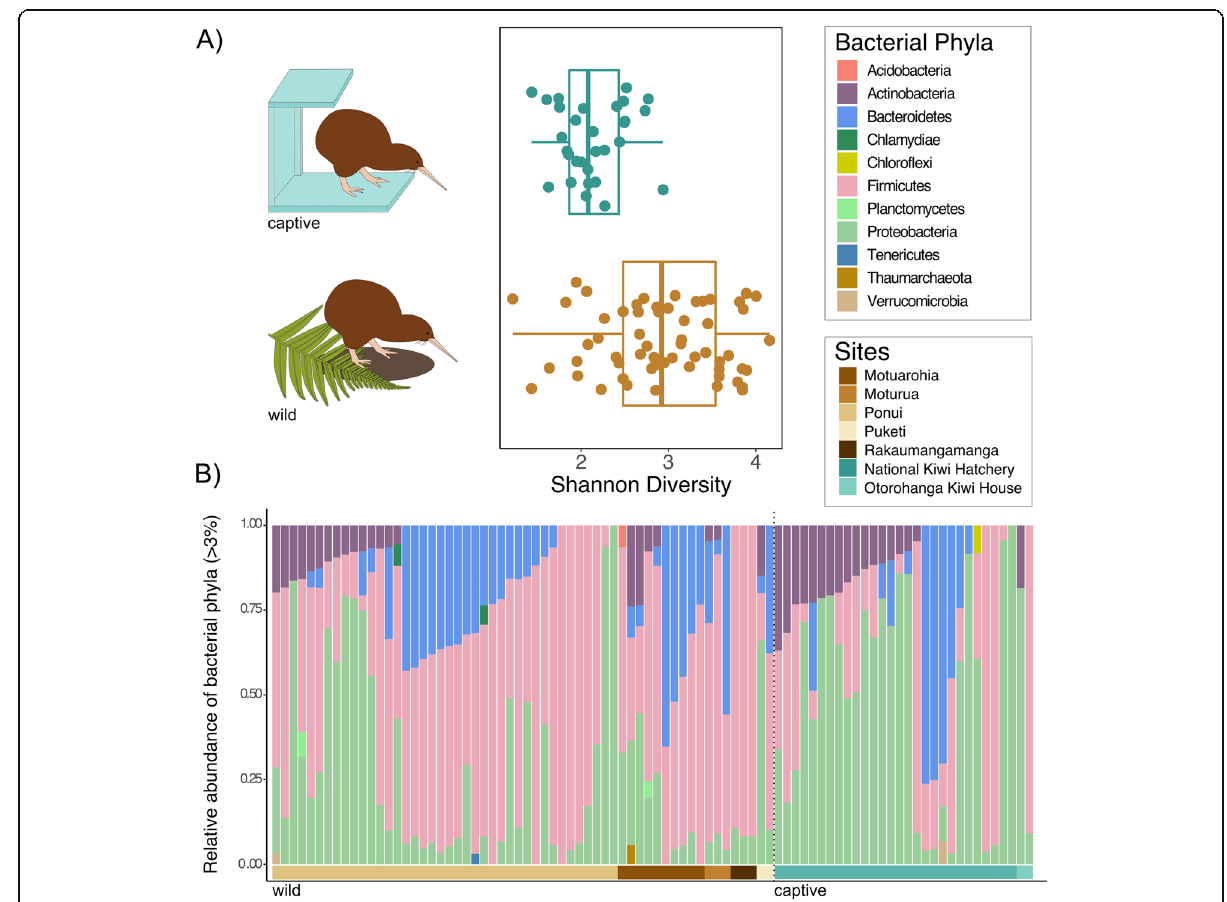
Fig. 2 The Brown Kiwi bacterial community differs both in diversity and composition due to captivity status . A Alpha diversity of captive kiwi is significantly reduced compared to wild individuals (linear model, r 2 = 0.288, p < 0.001). B Relative abundances of bacterial phyla present at > 3 % between captive and wild kiwi. Vertical bars show the bacterial taxa and horizontal bars denote the collection